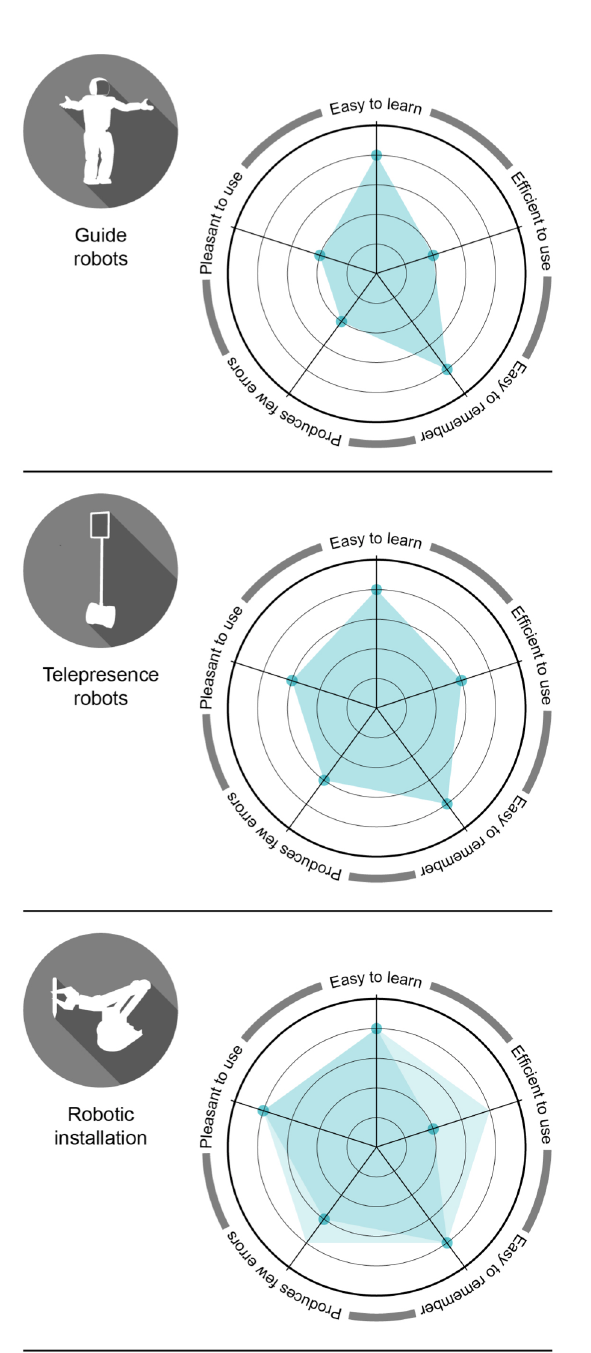
Figure 1 | Empirical usability evaluation of the three main categories of museum